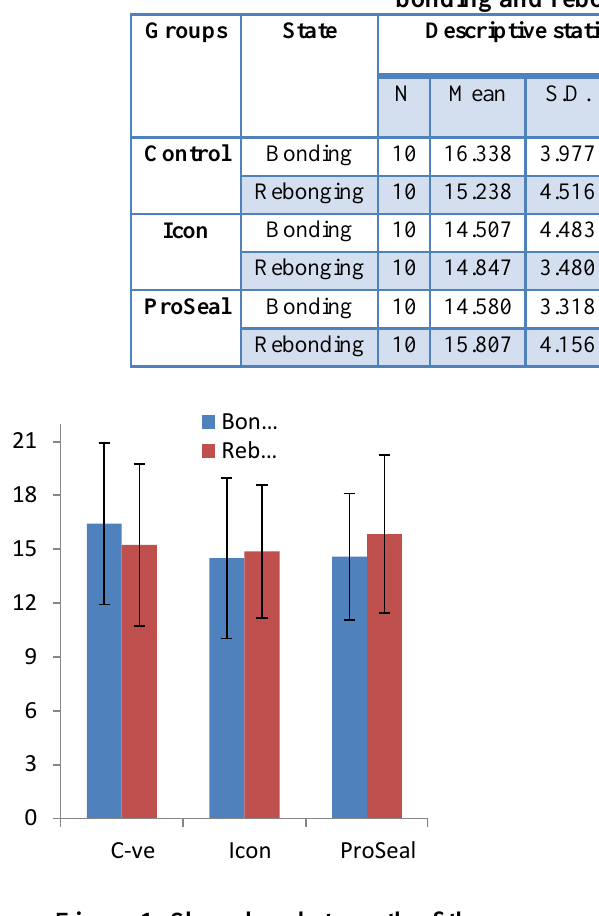
Figure 1: Shear bond strength of the bonding and rebonding groups. The error bars represent the standard deviation.